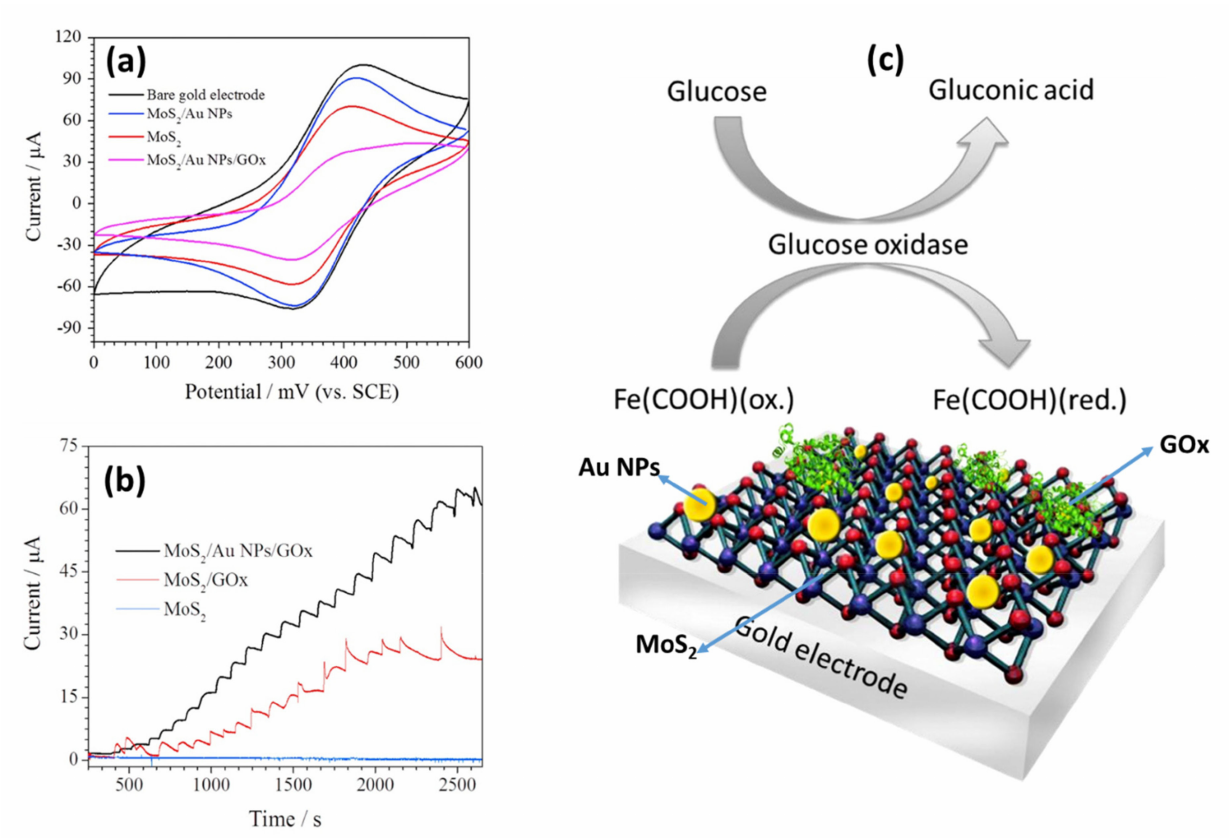
Figure 8. ( a ) CV response of bare and modified gold electrodes in 1 mM ferrocene carboxylic acid and 0.1 M PBS at 50 mV/s vs. Ag/AgCl reference electrode. ( b ) Amperometric responses of modified gold electrodes for the sensing of glucose concentration in the range from 0.25 to 13.2 mM at + 0.35 V applied potential. ( c ) Schematic representation of Au NPs decorated on a MoS 2 interface and a reaction mechanism on MoS 2 -AuNPs-GOx composite [69]. Figures reproduced with permission from Ref. [69], copyright © 2016 Elsevier